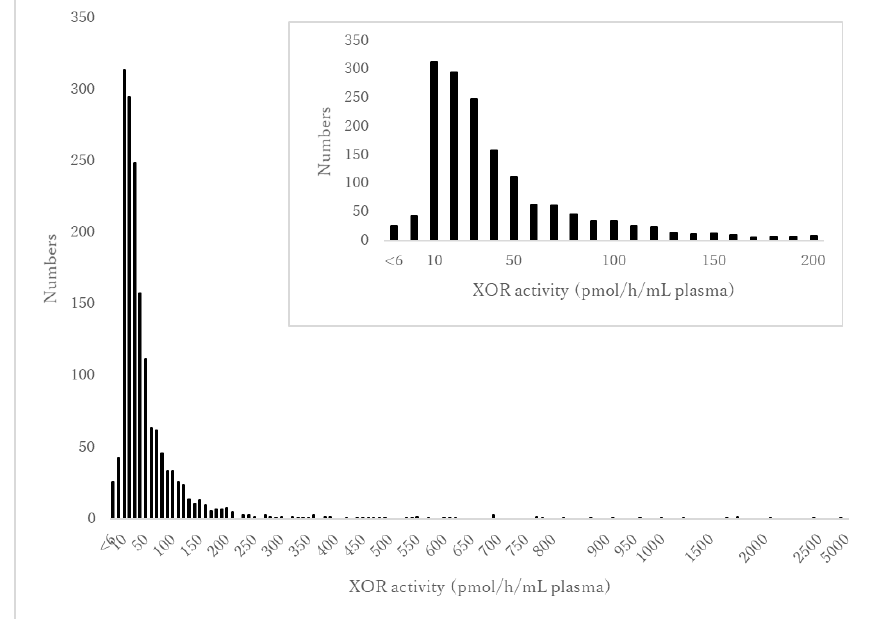
Figure 1. The distribution of XOR activity. The vertical axis indicates the number of participants. The horizontal axis shows XOR activity levels ranging from <6 to 4540 pmol/h/mL plasma in incre- ments of 50. The inset figure shows an enlarged version of the distribution of XOR activity in the range from <6 to 200 pmol/h/mL